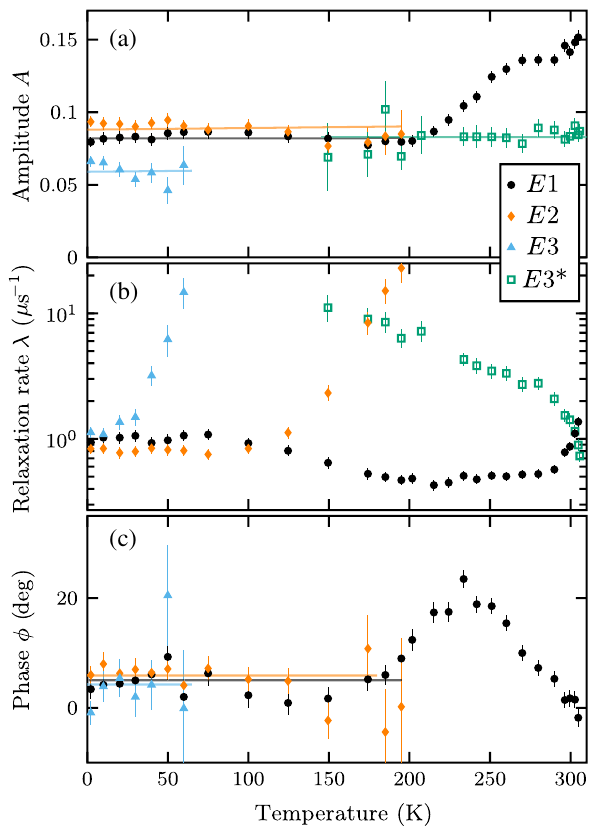
FIG. 2. Fit results for the three ZF oscillatory signals E 1 − E 3 as a function of temperature: (a) amplitudes A , (b) relaxation rates λ (logarithmic y axis), and (c) phase ϕ . Note the pronounced peak at around 240 K in the E 1 phase, indicating a transition process between muon environments. Lines are guides to the eye. Additionally, the amplitude and relaxation rate for E 3 (cid:3) are shown; see Sec. III B 2.